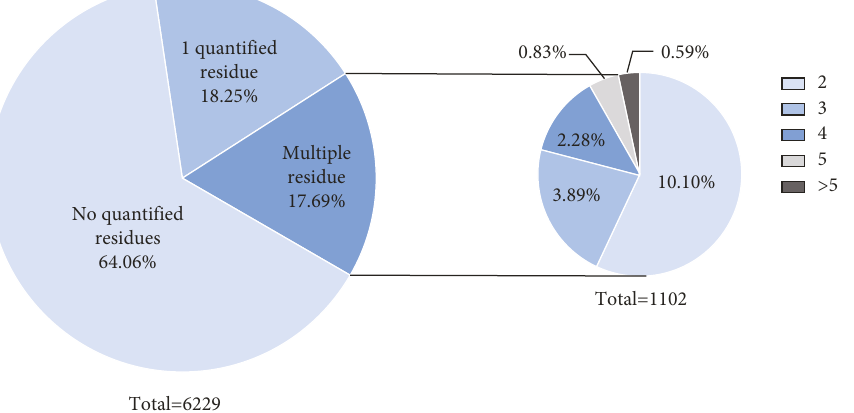
Figure 3: Proportions of pesticide residues in a single brown rice